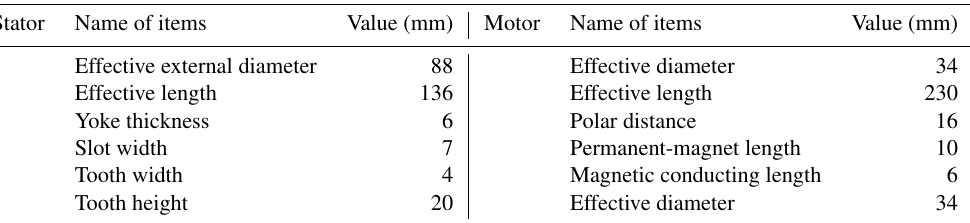
Table 1. Generator parameters.